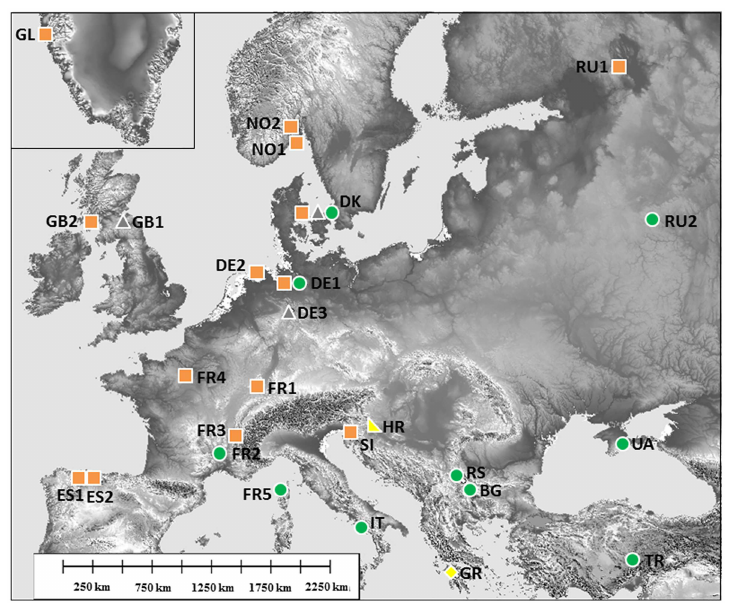
Fig 1. Sampling locations and distribution of lineages of Parisotoma notabilis . Genetic lineageswere namedfollowingPorco et al. (2012), lineageL0 (grey triangles)occurs in three samplinglocations(DE1, DK, GB1), while lineages L1 (green circles) and L2 are widespread in the southwest and the east of Europe, respectively. LineagesL3 (yellowdiamond) and L4 (yellow turned triangle) are geographically isolated in the south of